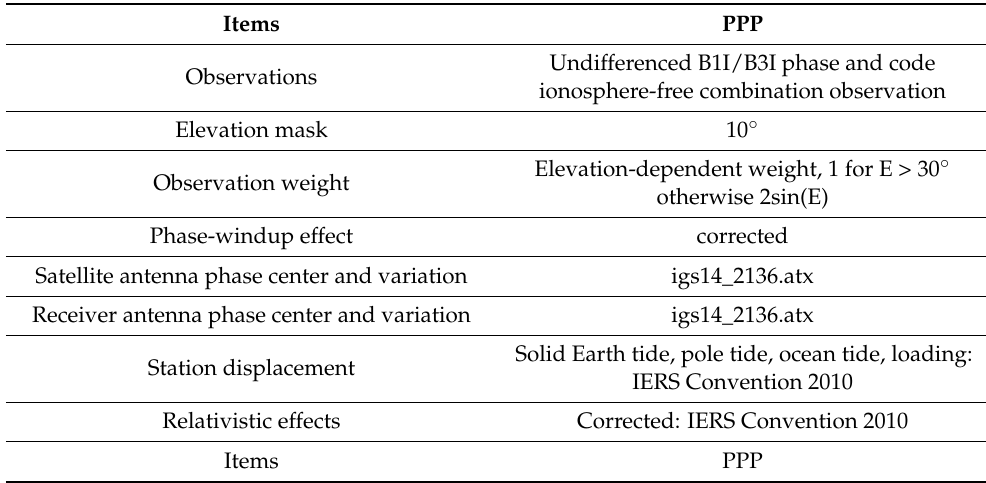
Table 2. Models and parameters for